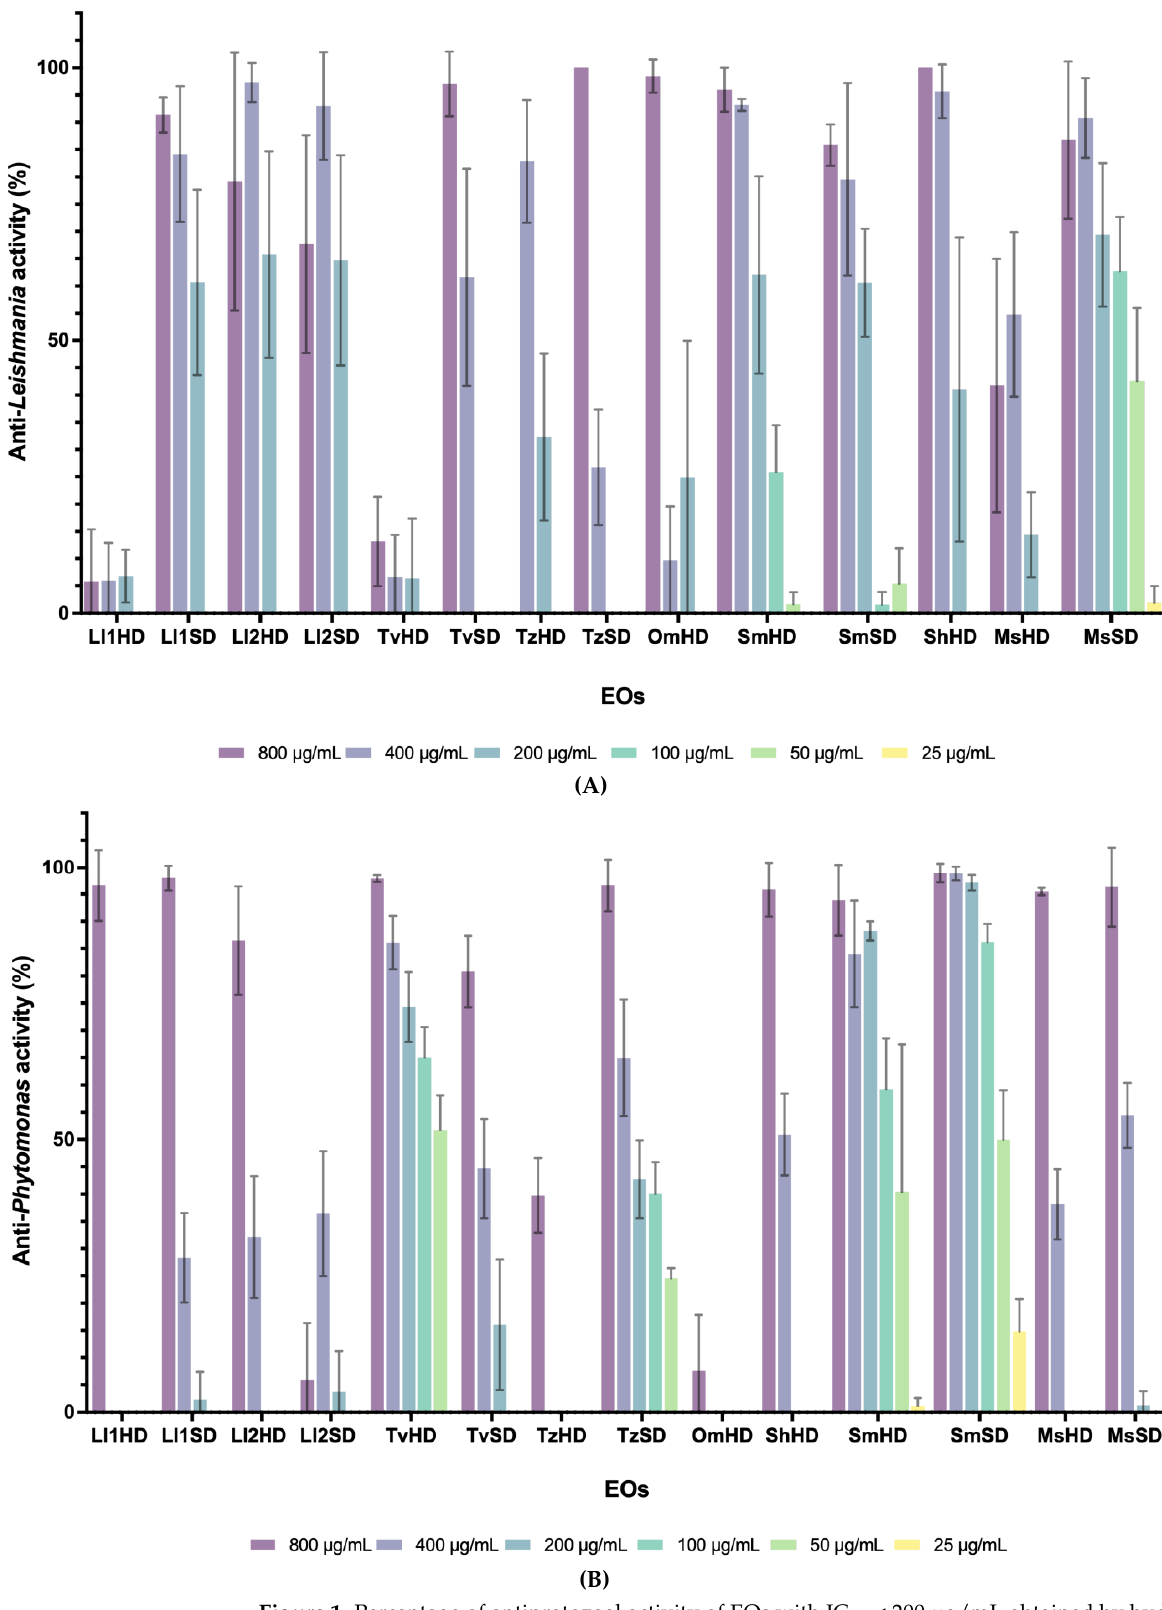
Figure 1. Percentage of antiprotozoal activity of EOs with IC 50 < 200 µg/mL obtained by hydrodis- tillation (HD) and steam distillation (SD) from L. luisieri 1 and 2 (Ll1 and Ll2), T. vulgaris (Tv) , T. zygis (Tz), O. majorana (Om), S. hybrid (So), S. montana (Sm), and M. suaveolens (Ms). ( A ) Anti- Leishmania activity. ( B ) Anti- Phytomonas activity of EOs. EOs belonging to S. montana, M. suaveolens , and R. officinalis had effects on both par- asites. Differences related to the EO extraction method were observed for R. officinalis against both parasites (Figures 1 and S1). S . montana EOs had the highest antiprotozoal activity against both parasites and the AP activity was maintained even at 100 µg/mL. Among the four EOs from Salvia spp., two were highly active against L. infantum , and two had no activity (Table 1). The EOs with the largest effects were S. hybrid (HD) and S. offic- inalis (SD). Worse results were obtained against Phytomonas , with three EOs having mod- erate effects and one showing no activity. S. officinalis was the Salvia species with the high- est anti-Trypanosomatidae activity. The EOs from Origanum and Thymus spp. showed high or moderate activity against Leishmania . The best AL effects were obtained for T. zygis , and T. vulgaris (SD EOs). On P. davidi, T. vulgaris (HD) showed the highest activity at 200 µg/mL . No activity against Phytomonas was found for T. mastichina , T. zygis (HD), or O. majorana . The EOs from the Asteraceae ( Tanacetum , Santolina , and Ditrichia) showed moderate antiprotozoal activities, except for T. vulgare which showed no activity on P. davidi and L. infantum. Overall, antiparasitic results of the tested EOs showed that L. infantum was more sen- sitive to the EOs than P. davidi (50% vs. 30% active EOs: IC 50 < 500 μg/mL). The most active EOs against P. davidi (IC 50 < 100 μg/mL) were S. montana (SD), T. vulgaris (HD) and S. montana (HD), whilst for L. infantum they were M. suaveolens (SD), L. luisieri 2 (SD), and L. luisieri 1 (SD). In general, the EOs extracted by SD performed better against L. infantum (100% SD EOs).